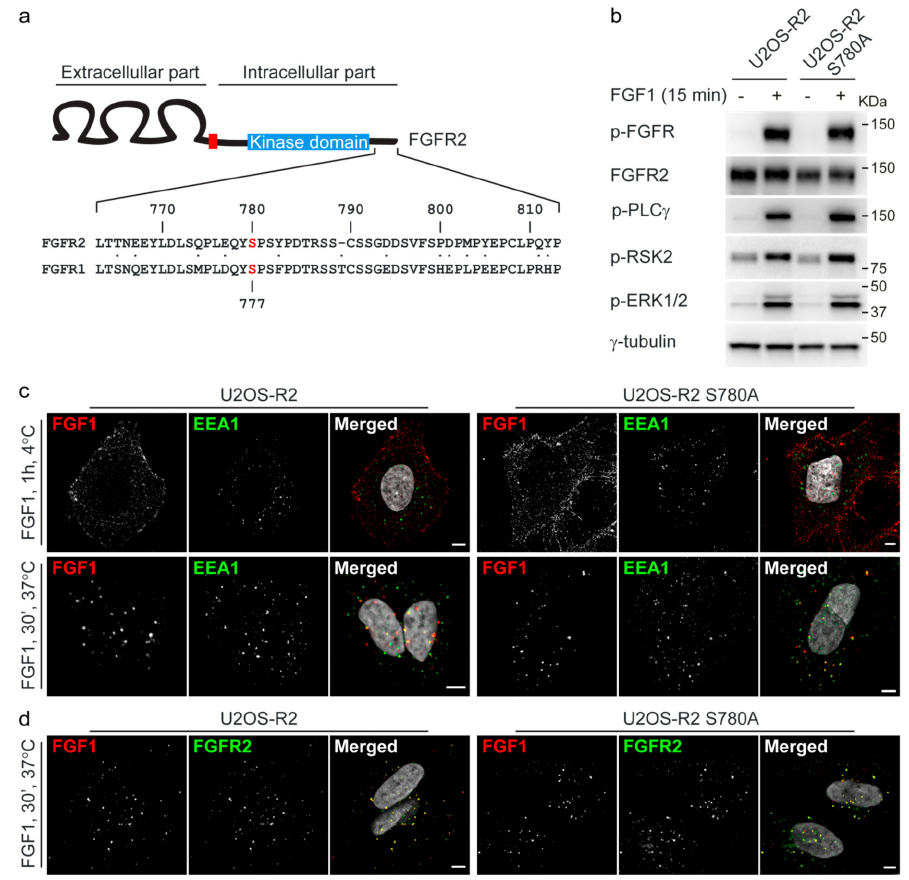
Figure 3. Characterization of cell lines stably expressing FGFR2 S780A mutant. ( a ) A pairwise sequence alignment tool from EMBL-EBI was used to align the C-terminal tails of FGFR2 and FGFR1. S780 in FGFR2 corresponds to S777 in FGFR1 (labelled in red in the figure). Numbers refer to the amino acid numbering used for human FGFR2 (NCBI: NM_000141). ( b ) U2OS-R2 cells or U2OS-R2 S780A cells were kept in serum-free media for two hours and then treated or not with 100 ng / mL FGF1 for 15 min in the presence of heparin (20 U / mL). After lysis, the cellular material was analyzed by immunoblotting using the indicated antibodies. A p in front of the name of the antibody indicates that it recognizes the phosphorylated form of the protein. One representative experiment is shown. ( c ) U2OS-R2 or U2OS-R2 S780A cells were kept at 4 ◦ C with DL550-FGF1 for one hour in the presence of heparin (50 U / mL). Next, the cells were either fixed directly (upper panel) or incubated for 30 min at 37 ◦ C before fixation (lower panel). The cells were then stained with anti-EEA1 antibodies and Hoechst and analyzed by confocal microscopy. Representative images are shown. Scale bar: 5 µ M. ( d ) U2OS-R2 or U2OS-R2 S780A cells were treated with 200 ng / mL DL550-FGF1 in the presence of heparin (50 U / mL) for 30 min. The cells were then fixed, stained with anti-FGFR2 antibodies and Hoechst, and analyzed by confocal microscopy. Representative images are shown. Scale bar: 5 µ